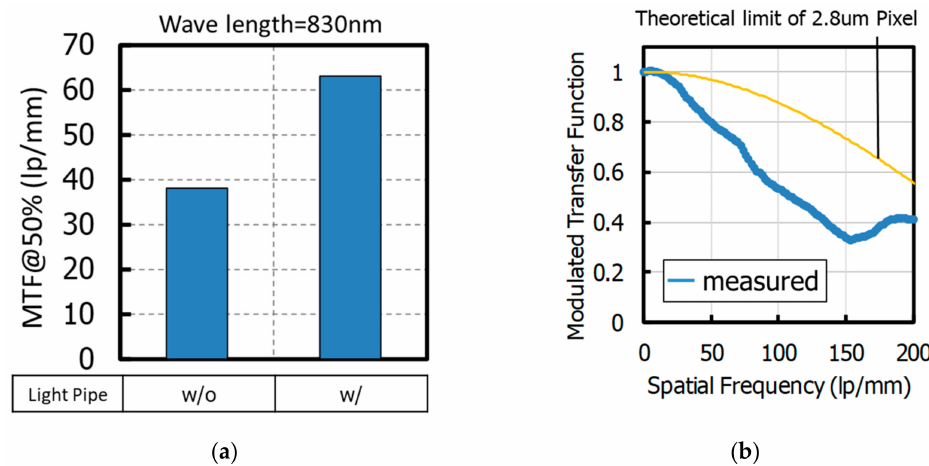
Figure 19. ( a ) Comparison of an MTF@50% contrast of a pixel with a light pipe and without a light pipe (wavelength is 830 nm, including the MTF of the camera lens). ( b ) Spatial frequency dependence of the MTF of a pixel with a light pipe (wavelength is 940 nm not including the MTF of a camera lens). MTF: modulation transfer